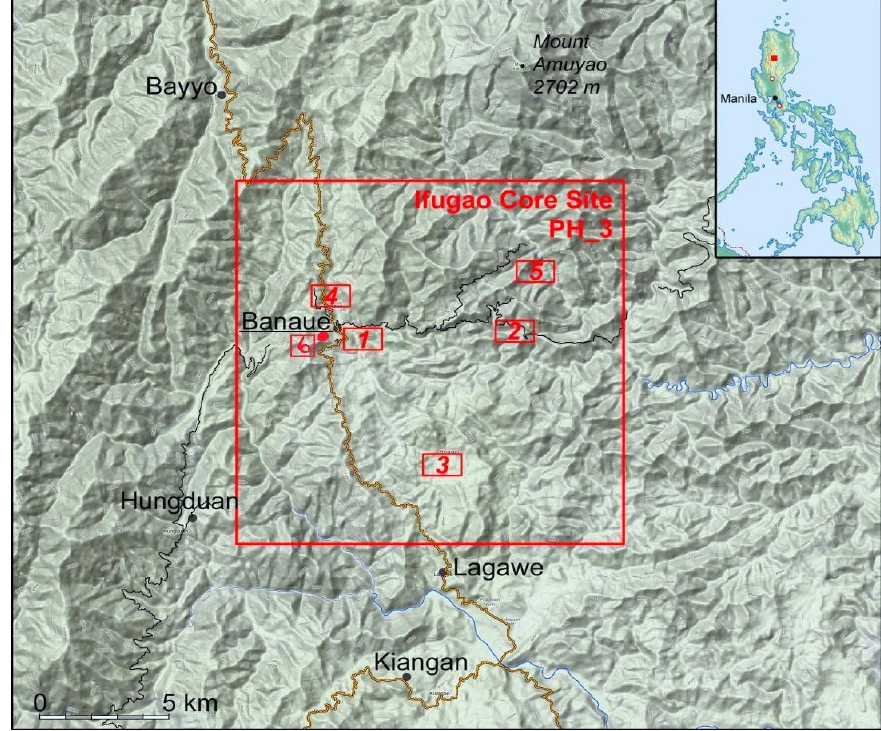
Figure 1. Sketch map of the Philippines with zoom into the researched study sites (Figure 2) in the Ifugao region (red quadrate of 15 × 15 km 2 ): 1 = Poitan, 2 = Bangaan, 3 = Hingyon, 4 = Banaue Viewoint, 5 = Batad, 6 = Banaue (source: ©2015 Google; Image ©2015 CNES/Astrium / Image ©2015 DigitalGlobe; modified by Reinhold